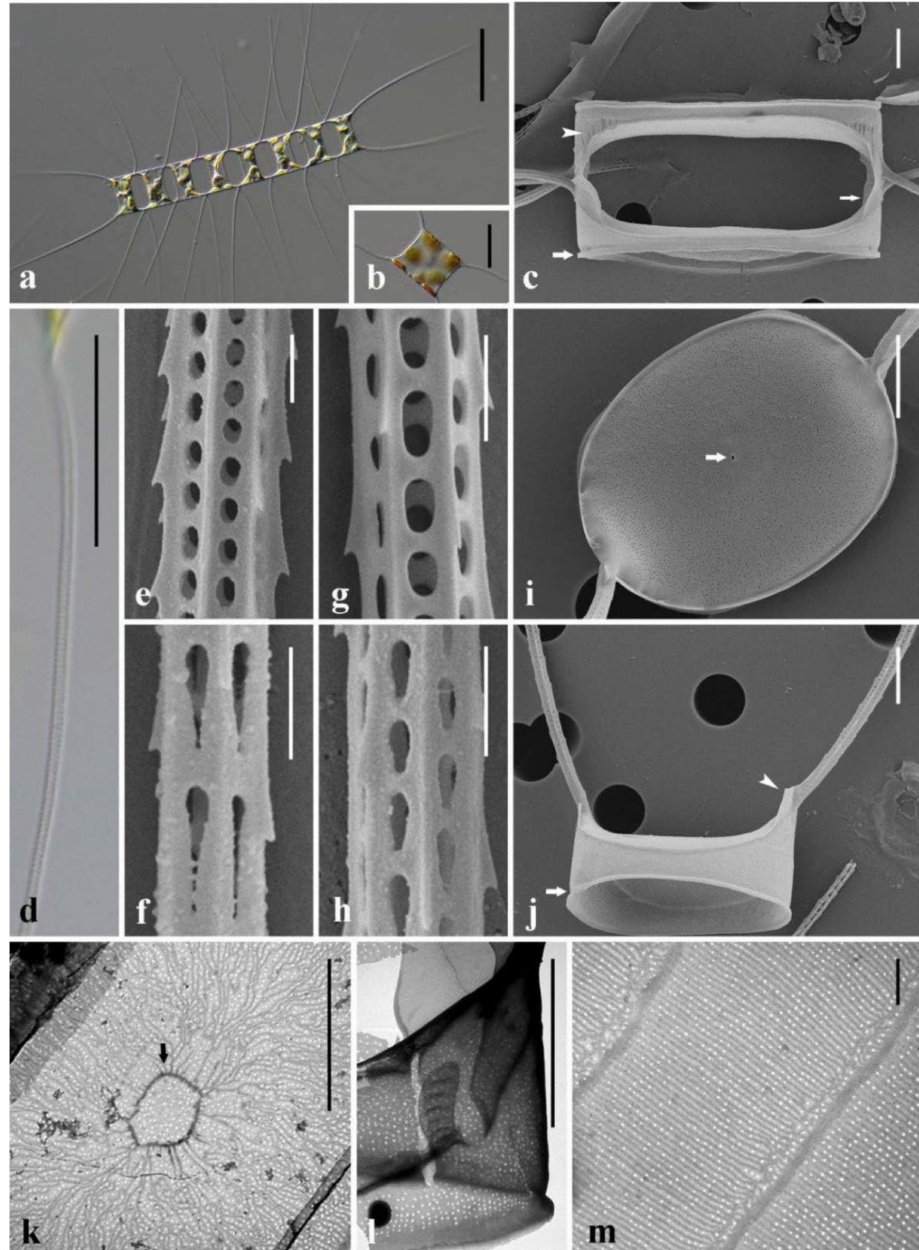
Figure 4. LM ( a , b , d ), SEM ( c , e – j ) and TEM ( k – m ) micrographs of vegetative cells of Chaetoceros densoelegans sp. nov., strain MC687. ( a ) Chain in broad girdle view; ( b ) solitary cell; ( c ) sibling intercalary valves showing aperture and overlapping silica ear-like structures (arrow), silica ridges (arrowhead) and furrow above the basal ring of mantle (broad arrow); ( d ) terminal seta under LM, showing visible setae poroids; ( e – h ) setae structure, showing round-oval and tear-shaped poroids on terminal ( e , f ) and intercalary setae ( g , h ), respectively; ( i ) terminal valve view showing external process of rimoportula (arrow); ( j ) terminal valves with silica ear-like structures (arrowhead) and furrow above the basal ring of mantle (arrow); ( k ) enlargement of intercalary valve, showing annulus (arrow), costae and poroids; ( l ) parallel rows of poroids on the mantle; ( m ) close-up of bands. Scale bars: ( a , b , d ) 20 µ m; ( c , i – l ) 5 µ m; ( e – h , m ) 1 µ